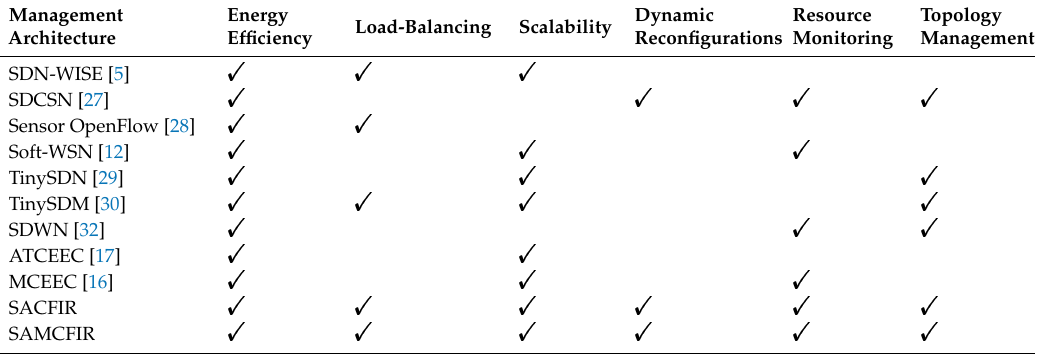
Table 1. SDN-based sensor network and topology management architectures. WISE, WIreless